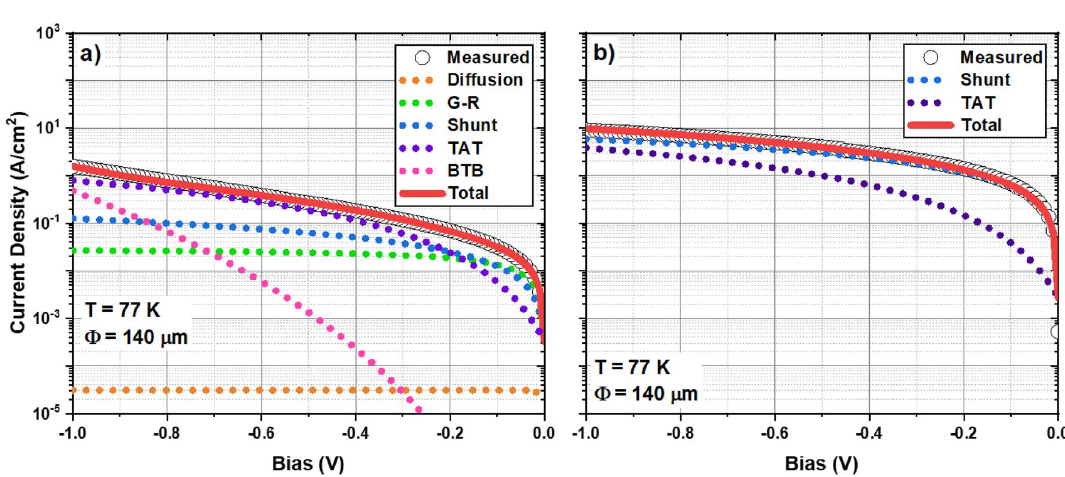
Figure 6. The measured and fitted dark current densities at 77 K for Sample C ( a )and Sample D ( b